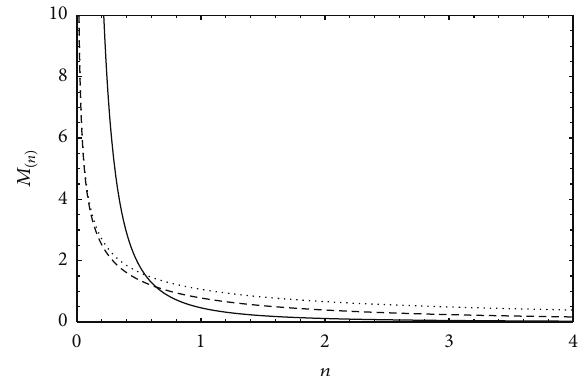
𝜓 (𝑛) for the first